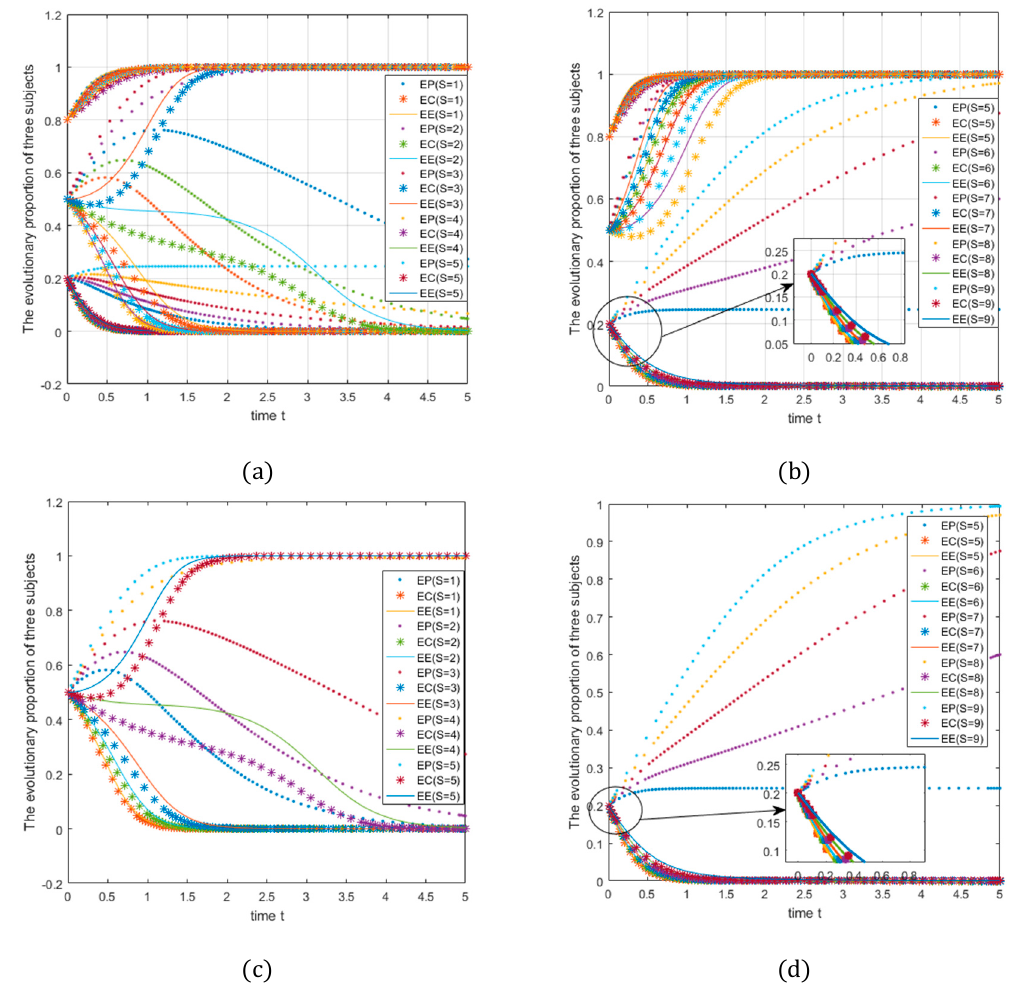
Figure 10. Impact of changes in the amount of subsidies on system evolution.